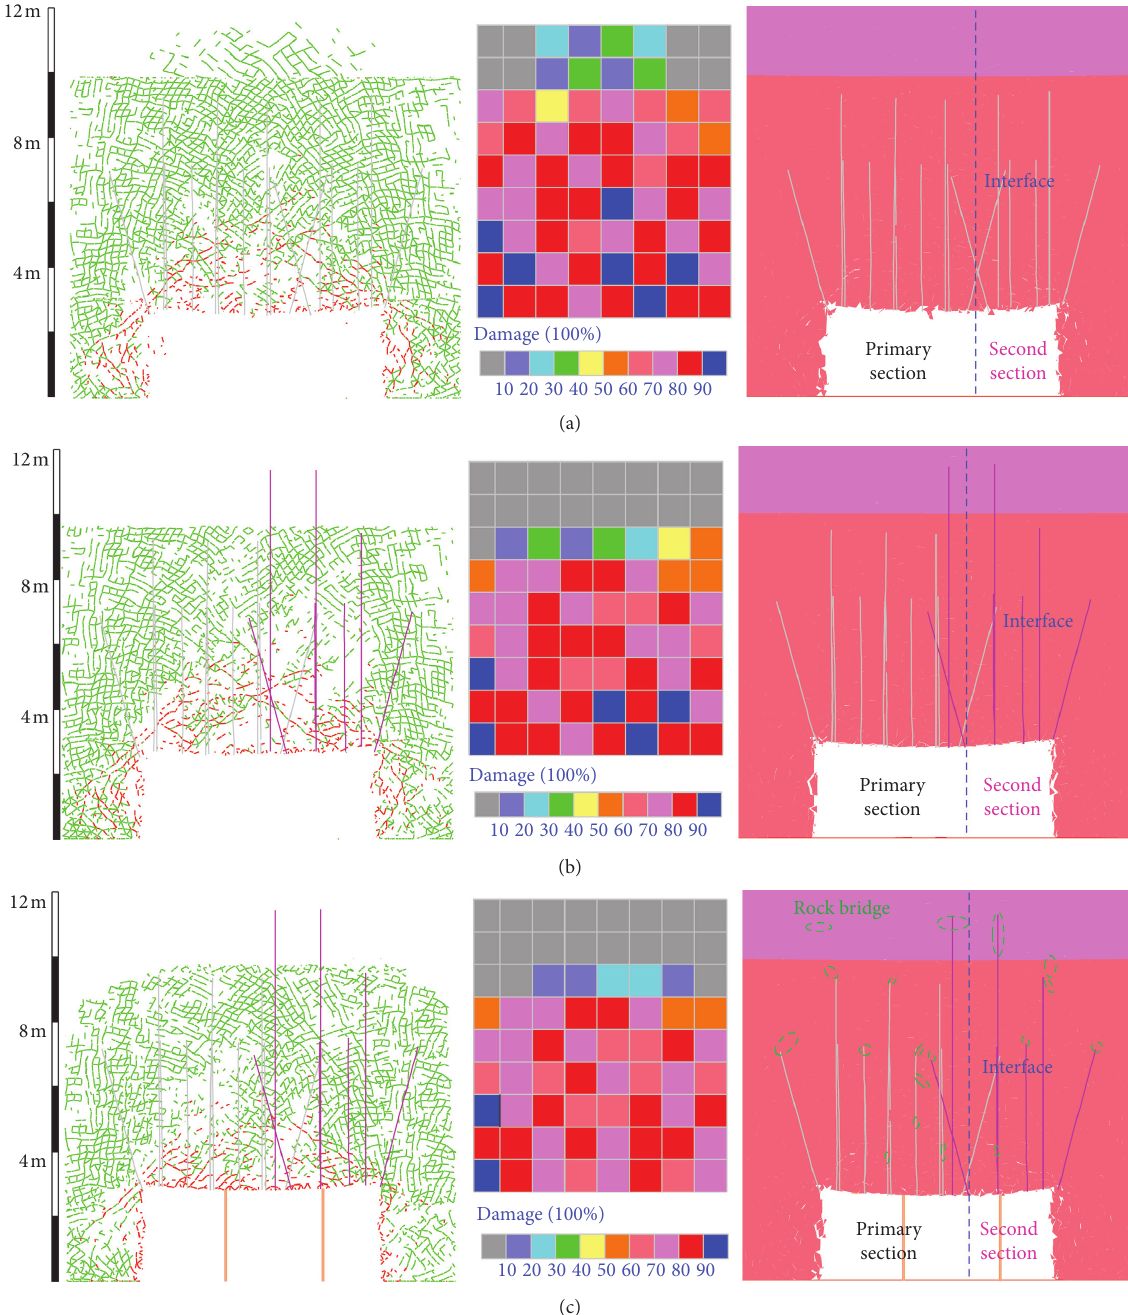
Figure 12: Distribution, damage, and failure modes of roof cracks in three support schemes, (a) Scheme 1; (b) Scheme 2; (c) Scheme 3. (The green cracks represent tensile cracks, and the red cracks represent shear